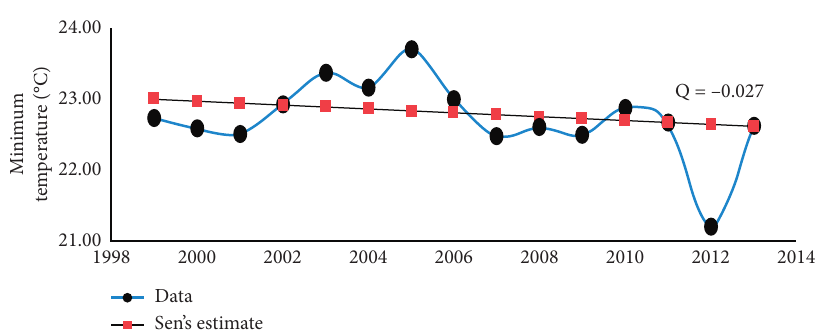
Figure 4: Mean annual trend in minimum temperature in the Bawku Municipality.